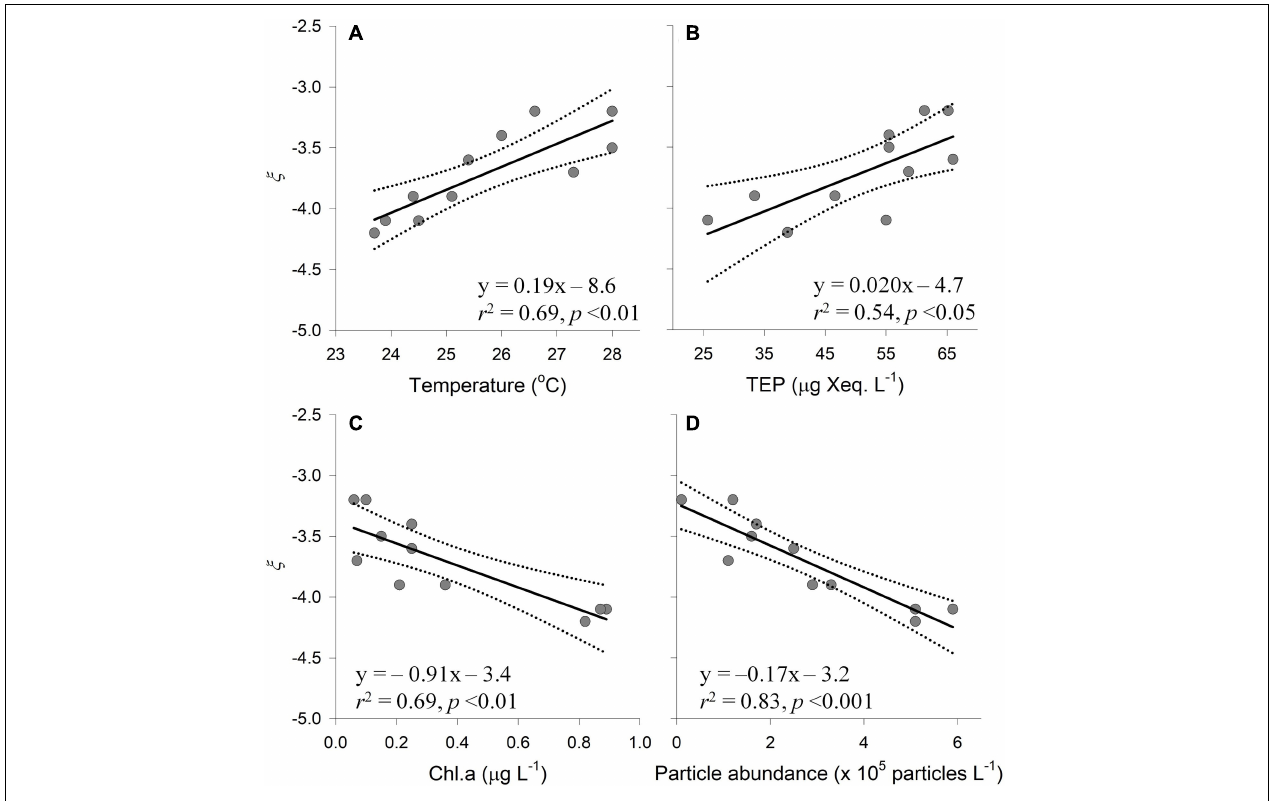
FIGURE 7 | Relationships between the slope of particle size distribution ( ξ ) in the size range of 5.2–119 µ m and other variables. Scatter plots of the PSD slope ( ξ ) against (A) temperature, (B) concentration of transparent exopolymer particles (TEP), (C) concentration of chlorophyll a (Chl. a ), and (D) particle abundance in the size range of 5.2–119 µ m. Linear regression line (solid line), 95% confidence interval (dotted line) and statistical parameters are given for each graph.